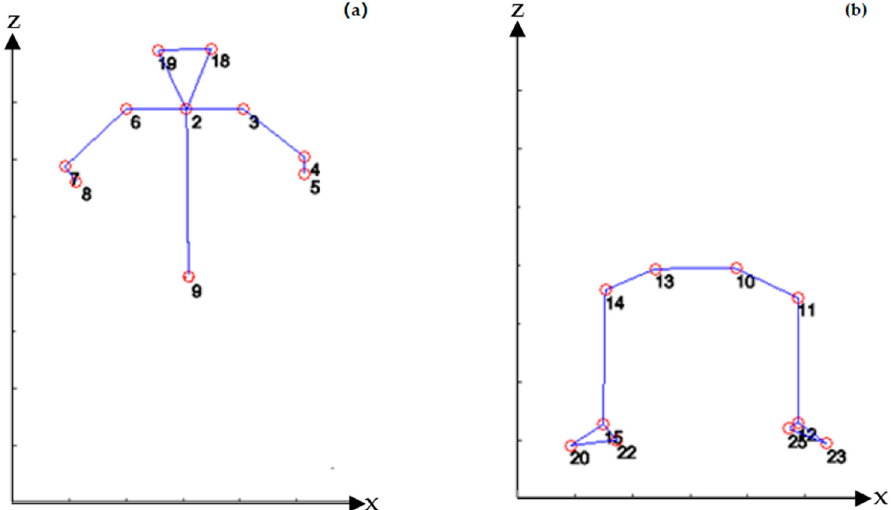
Figure 4. ( a ) The top 10 points as network input; ( b ) the bottom 10 points as a network target.